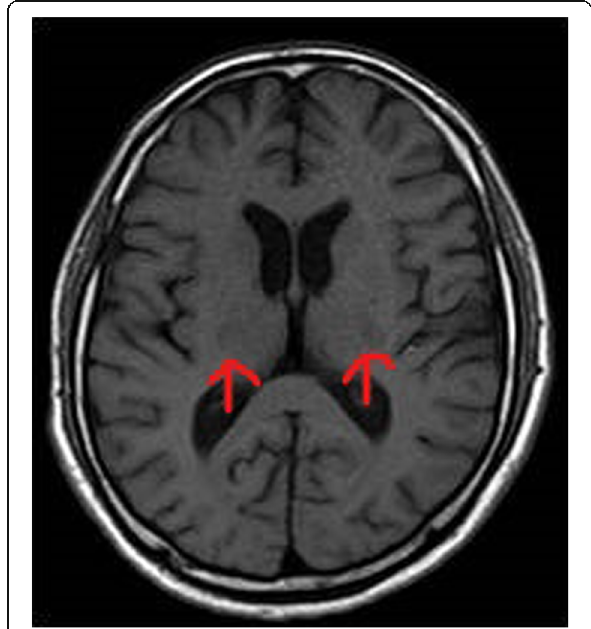
Fig. 4 Axial T1 WI at the level of ganglio-capsular region showing hypointensity in posterior limbs of bilateral internal capsules (red arrows)